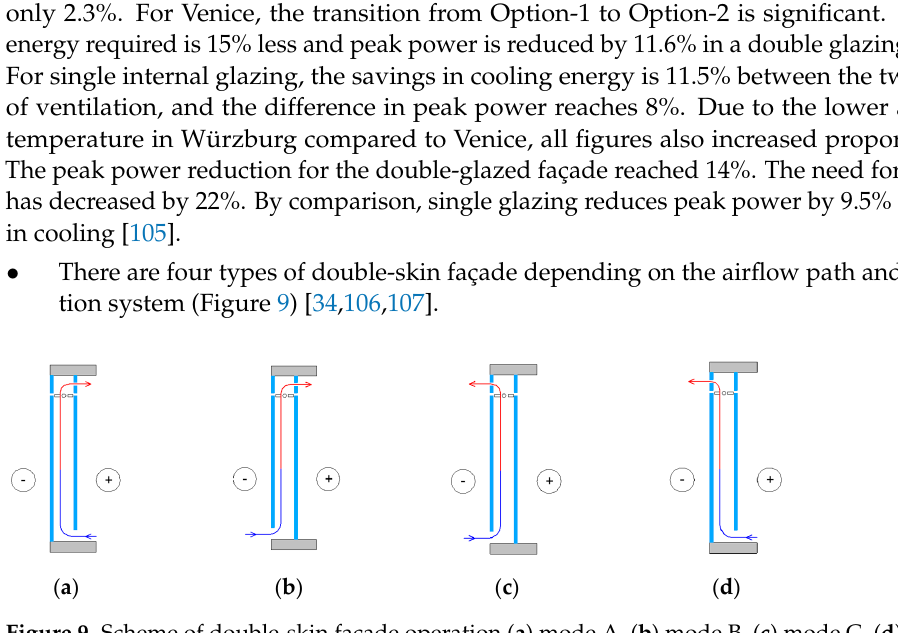
( b ) Figure 11 . Movable shading devices: ( a ) model of the façade element in winter and summer; ( b ) experimental installation (data from ref. [96]) .